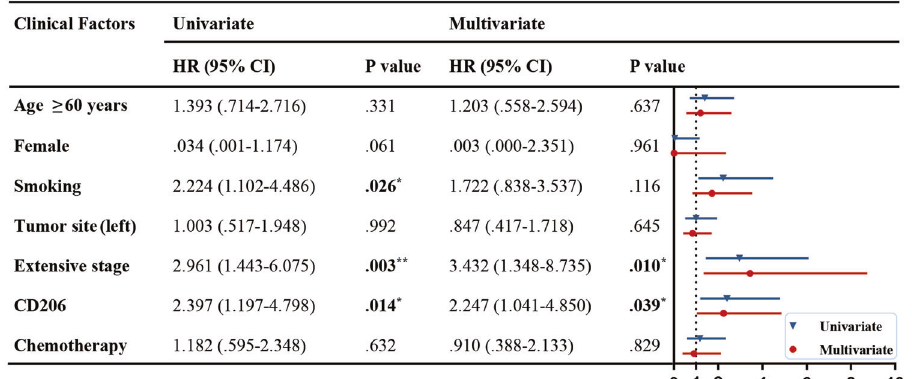
Fig. 2 Cox proportional hazard analysis of risk factors associated with overall survival. Hazard ratios (95% con fi dence intervals) are shown for the risk factors associated with overall survival. Boldface type indicates statistical signi fi cance; * P < 0.05, ** P < 0.01, *** P < 0.001. HR hazard ratio, CI con fi dence